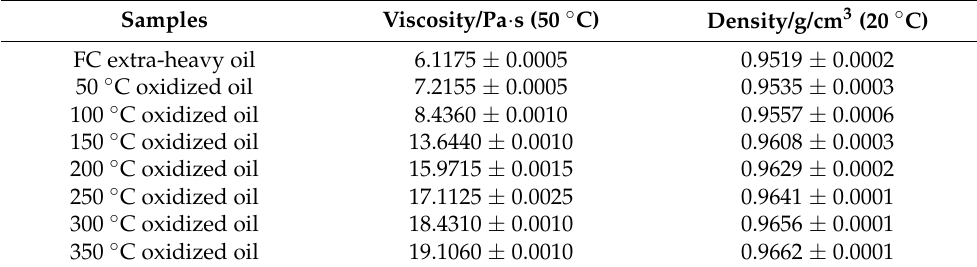
Figure 3. Viscosity–temperature curves of FC extra-heavy oil and oxidized oils. Table 3. Viscosity and density of FC extra-heavy oil and oxidized